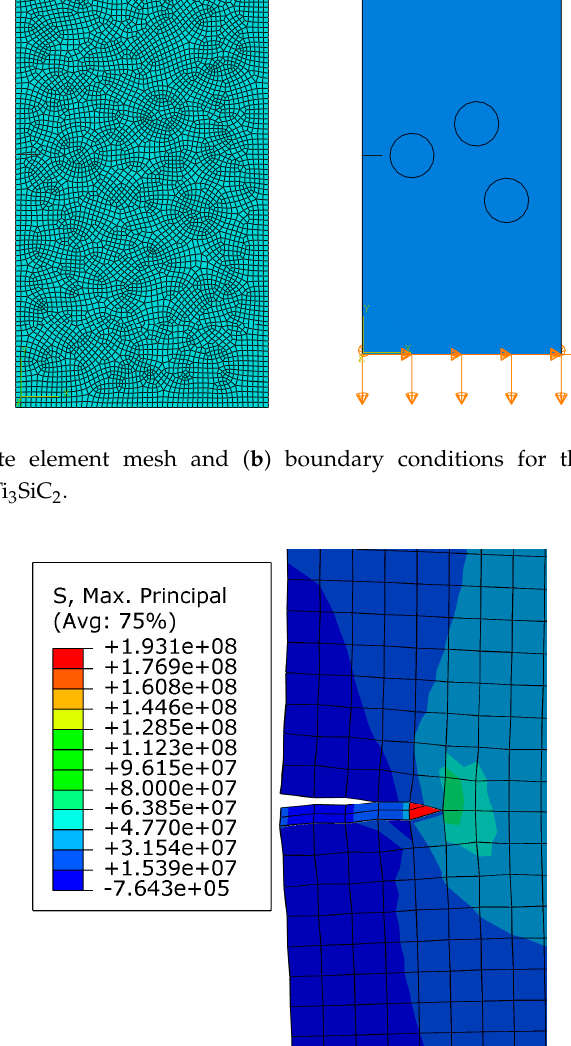
Figure 10. Predicted maximum principal stress distribution at the onset of crack propagation for the composite of SiC particle-reinforced Ti 3 SiC 2 .